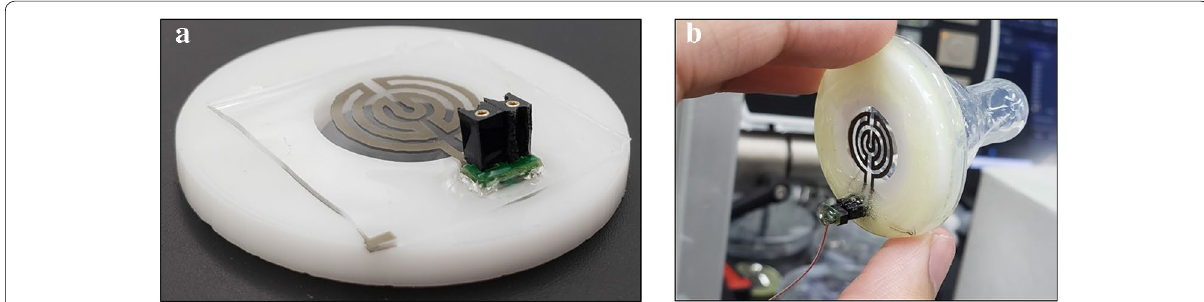
Fig. 2 a Strain gauge sensor placed on the connecting module and b fully assembled sensor with a commercial pacifier. The sensing region of the sensor is located in the central hole of the acrylic connecting module, where it can freely deform, while the external connection part of the sensor,